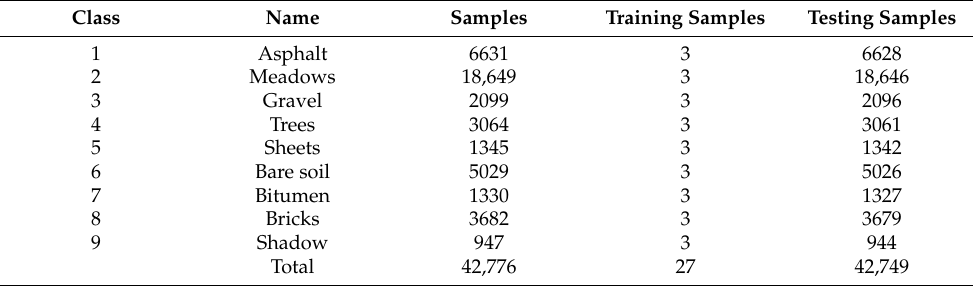
Table 2. Land cover classes and the numbers of samples in the PU data set.